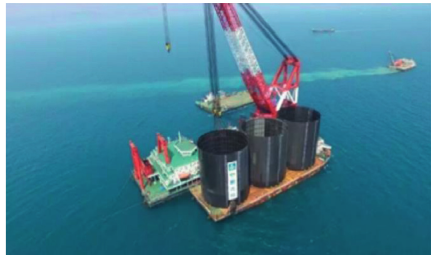
Figure 26: Backfilling sand